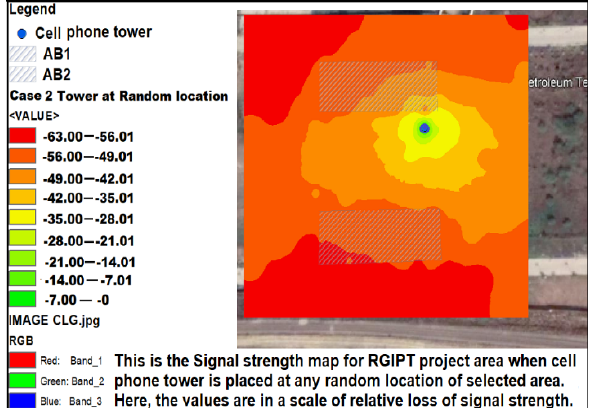
Figure 14. Cell phone tower at XY random